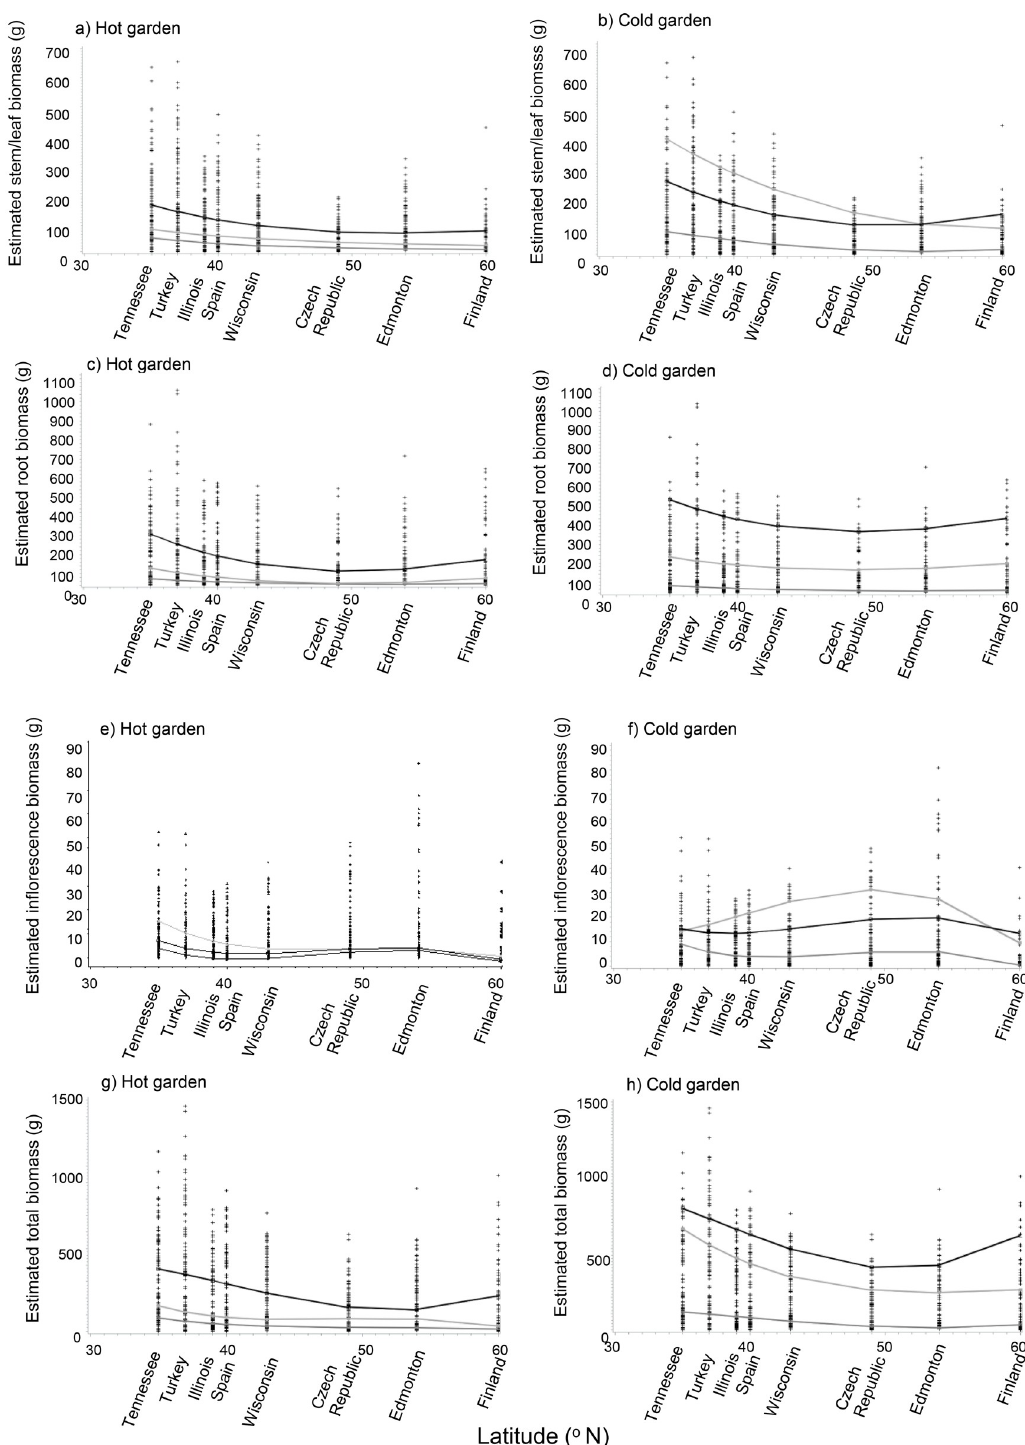
Fig 1. Oven-dried biomass (g) of various tissue types of Lythrum salicaria in two experimental gardens in T ř ebo ň , Czech Republic vs. Lafayette, Louisiana (cold/dry vs. hot/humid garden, respectively) including(a-b) above-ground stem/leaf, (c-d) below-ground root, (e-f) above-ground inflorescence and (g-h) total above and below-ground biomass pot -1 (g) versus latitude of seed origin during 2006, 2007, and 2008 (light gray, gray and black lines, respectively). Populations from seeds collected on the same continent as the common garden are designated in bold font. See Table 1 for the ANOVA table.